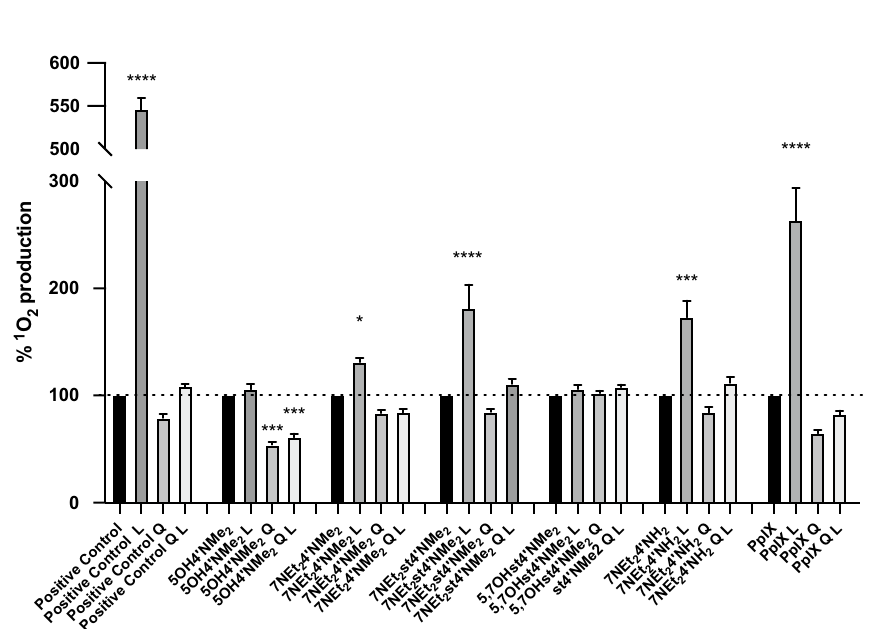
Figure 3. Oxygen singlet production by the compounds through Singlet Oxygen Sensor Green assay. The compounds were prepared in the different solutions at a final concentration of 25 μM. The fluorescence was registered before and after light irradiation (79.2 J cm −2 ) at ex/em 488/525 nm. As positive control methylene blue at 10 μM was used. L result after light irradiation; Q result in the presence of the quencher NaN 3 10 mM; QL result after light irradiation in the presence of the quencher NaN 3 10 mM. Each value represents the mean ± SEM (n = 8–16). *Means significantly different to the treatment control with the white light (****p value < 0.0001, ***p value < 0.001, *p value < 0.05). To perform both statistical analysis, ordinary one-way ANOVA with multiple comparisons between all means of each column was